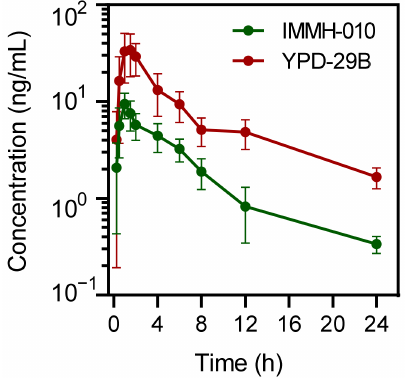
Figure 8. Mean plasma concentration-time profiles of IMMH-010 and active metabolite YPD-29B in male monkeys after oral administration of IMMH-010 maleate at a dose of 5 mg/kg ( n = 4). Data are expressed as mean ±